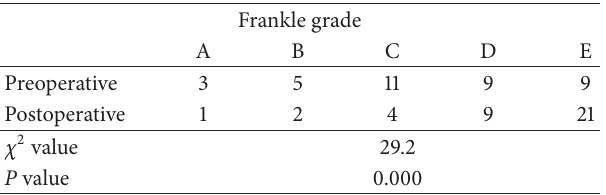
Table 1: The preoperative and final follow-up of neurological function was evaluated by Frankel